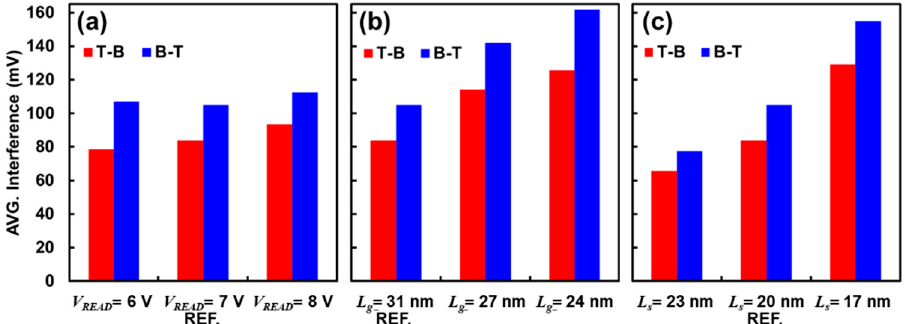
Figure 5. Averaged interference (P1P7, P2P7, . . . , P6P7, and P7P7) for T-B and B-T schemes with various changes such as ( a ) V READ, and cell dimensions, ( b ) gate length and ( c ) gate space, for the next generation vertical NAND Flash products. Note that the reference is ( V READ , L g , L s ) = (7 V, 31 nm, 20 nm) and the raw data of each case is available in Figure S1.